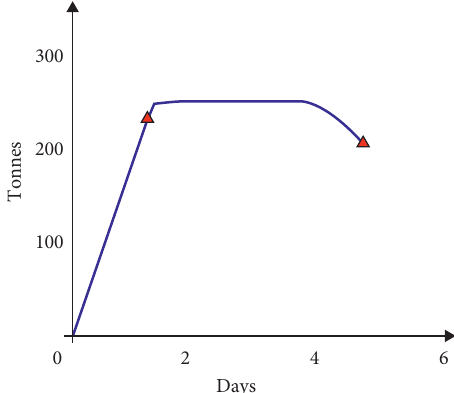
Figure 5: Progress of biomass graph for potato.